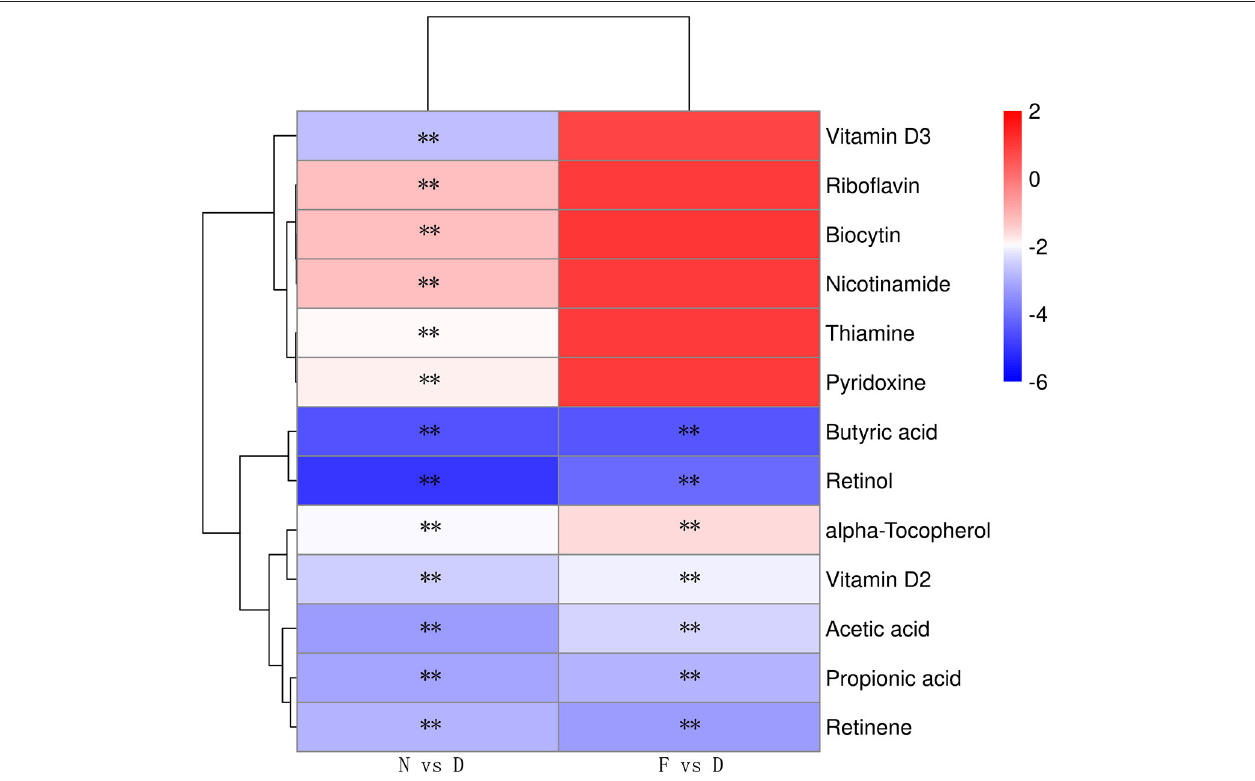
FIGURE 5 | Heatmap of the differential metabolites of vitamins and SCFAs ( n = 10). Serum samples were collected in the 48 day of age without MG challenge. **Indicates P <